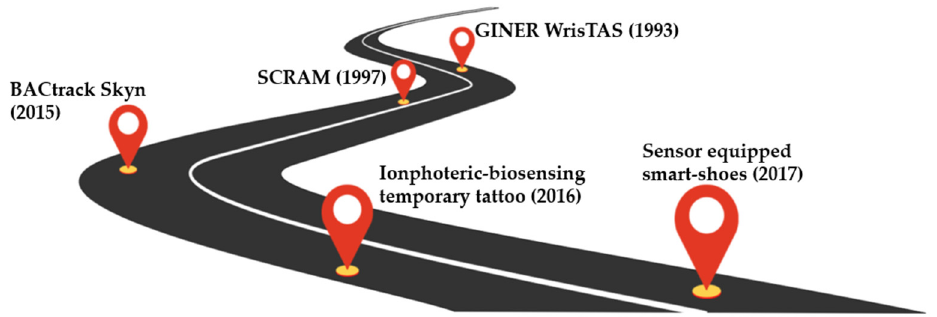
Figure 4. Roadmap of Flexible Electrochemical Biosensors for Alcohol Monitoring.